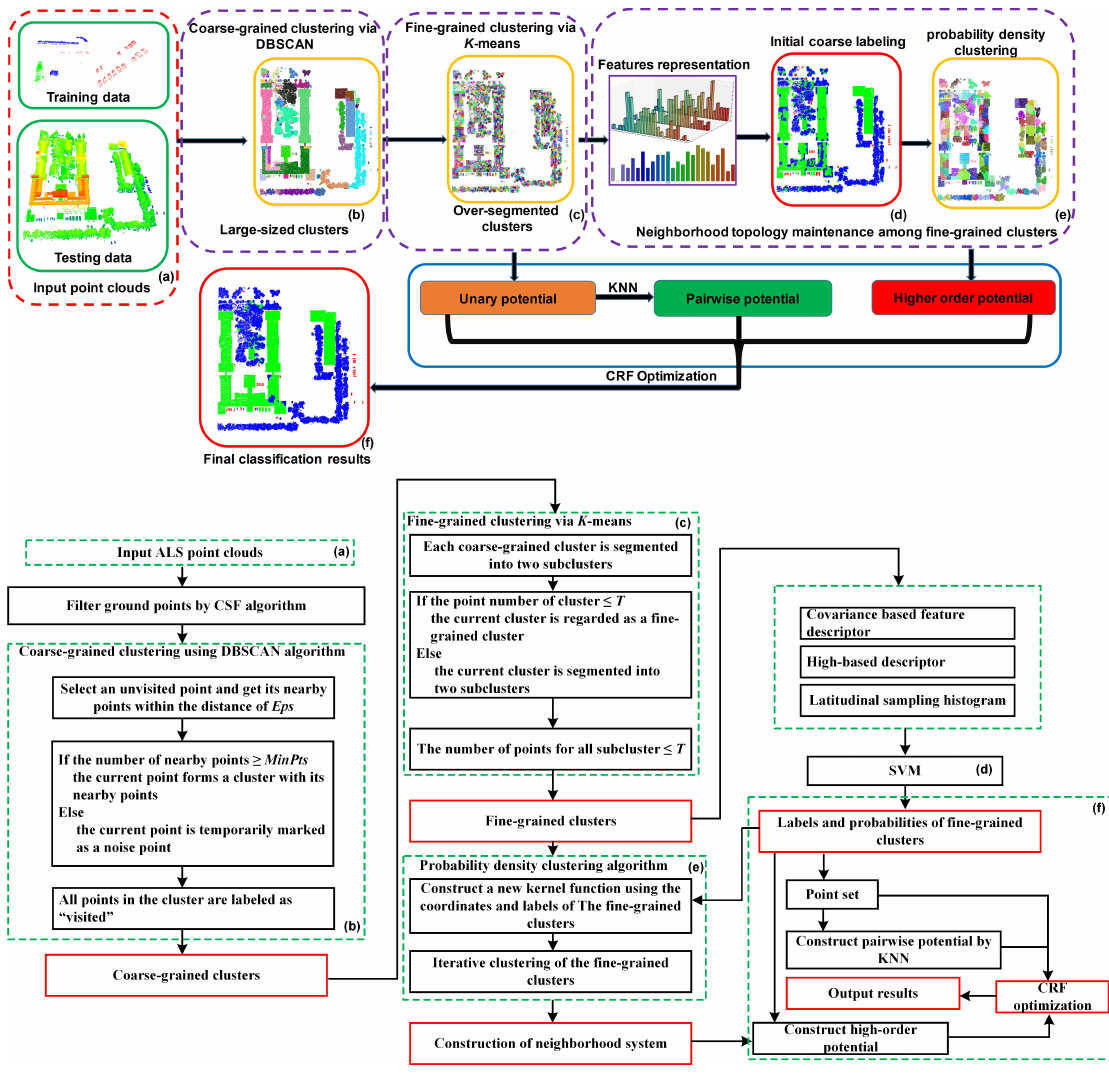
Figure 1. The flowchart of the proposed